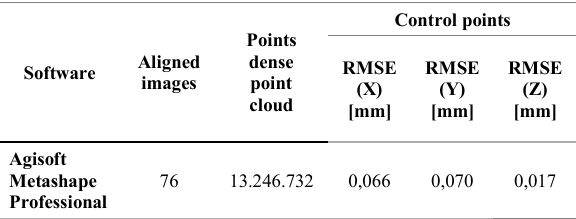
Table 5. Characteristics of the generated dense point cloud.